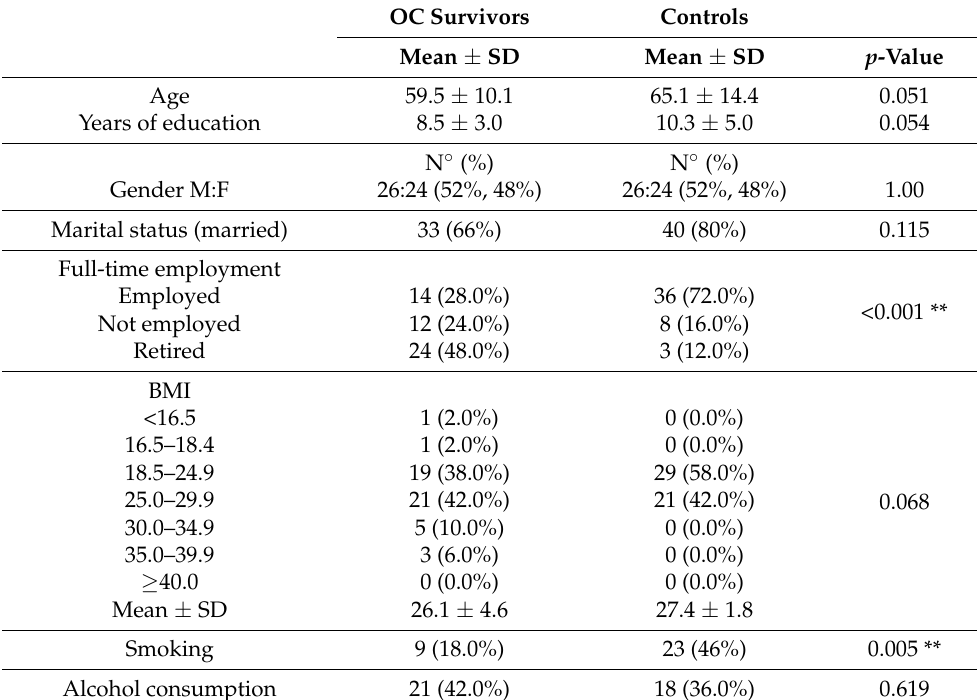
Table 1. Socio-demographic profile, body mass index, disease onset, and risk factors in the 50 OC survivors and 50